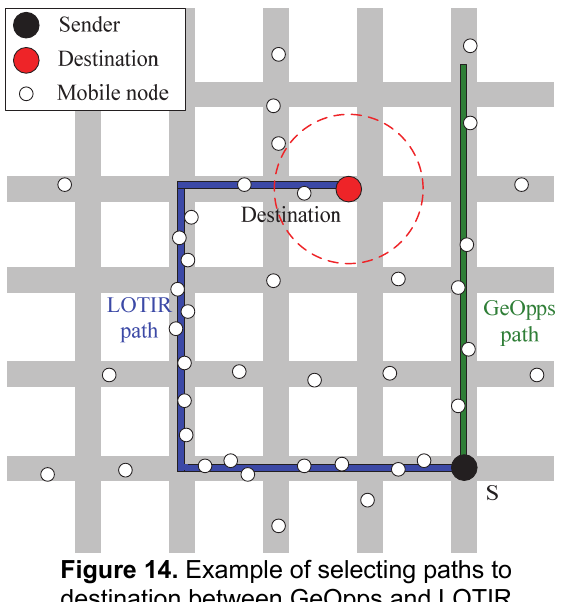
Figure 14. Example of selecting paths to destination between GeOpps and LOTIR